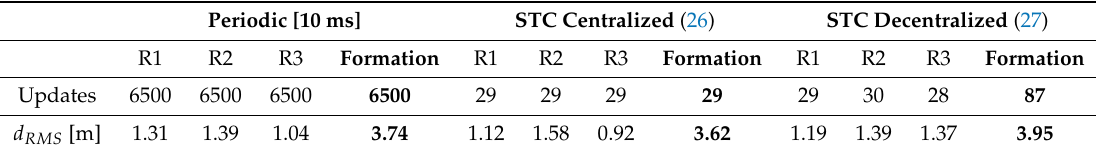
Table 1. Comparison of the update number and RMS value of distance error concerning the different control strategies for nonlinear, trajectory tracking (see Figure 4): periodic implementation, STC with centralized triggering (26) and STC with decentralized triggering (27).